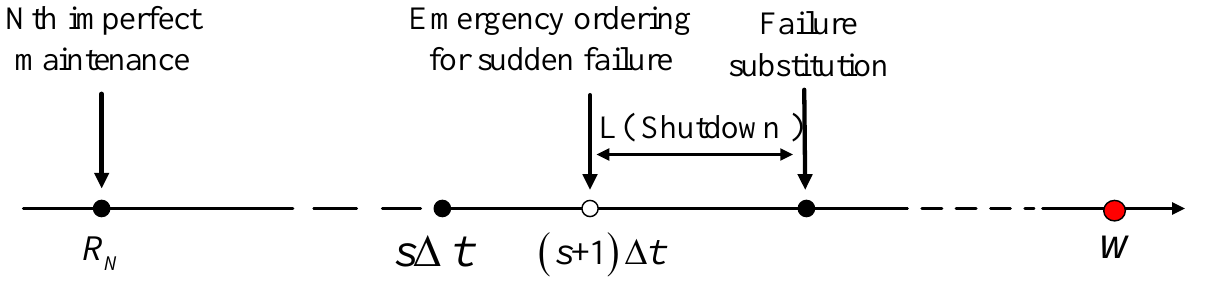
Figure 6. Failure replacement and spare parts ordering process 2.